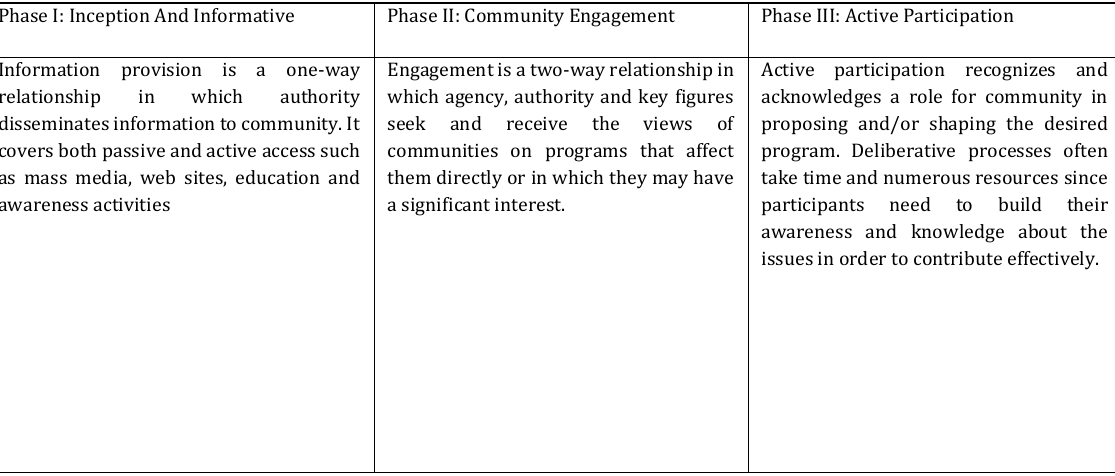
Table 1: Three different phases for